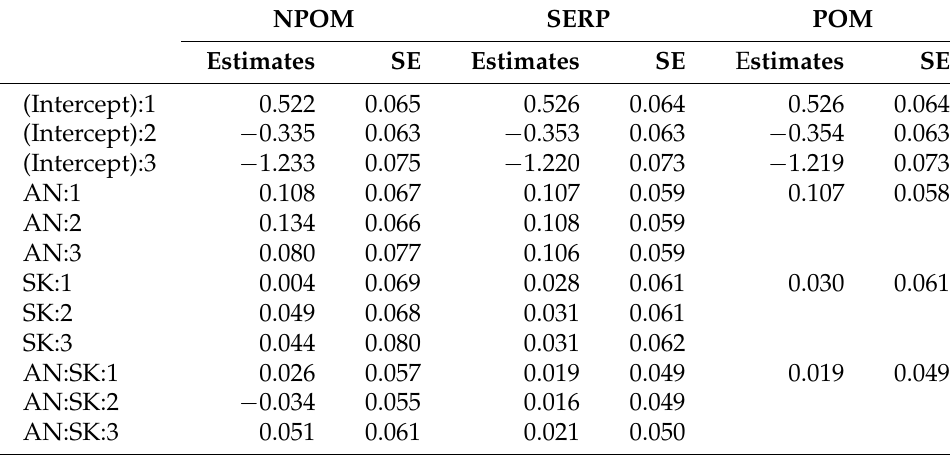
Table 3. Estimates and standard errors (SE) of regression coefficients in SERP and (N)POM for the sensory rating of panelist H, with androstenone (AN), skatole (SK) and interaction (AN:SK) as predictors of deviant